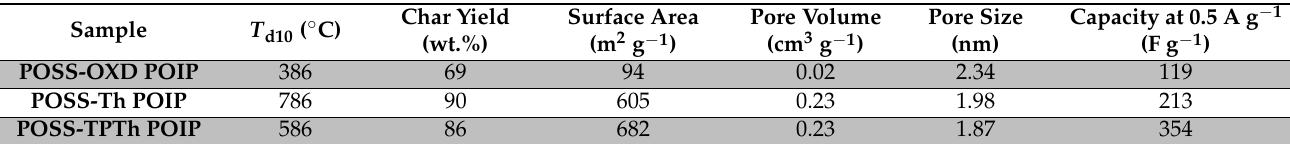
Figure 3. ( a ) TGA traces and ( b ) XRD patterns of the POSS-OXD, POSS-Th, and POSS-TPTh POIPs. Table 1. TGA, BET, and capacitance data for the POIPs.